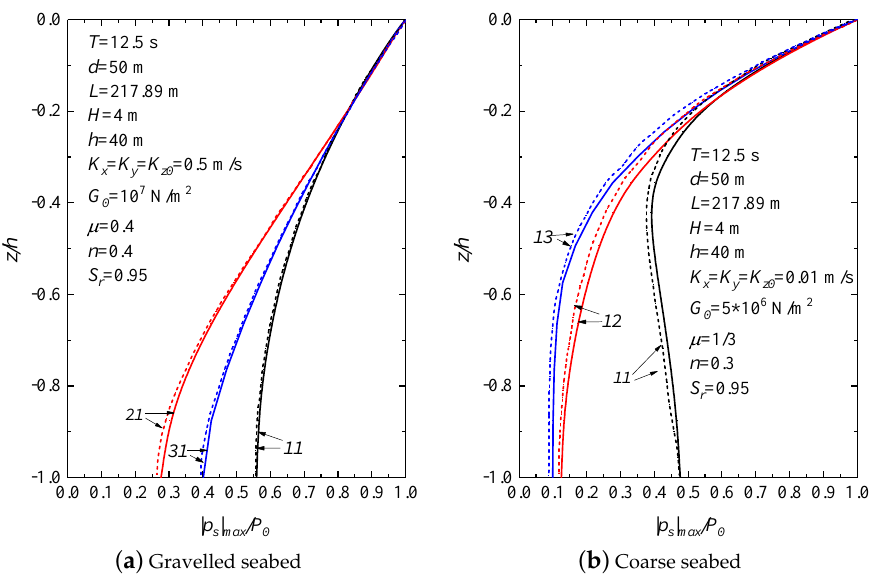
Figure 7. Vertical distribution of the maximum pore pressure in a non-homogeneous anisotropic seabed. The dashed lines are the results reproduced with permission from [14] and solid lines are the results of the present